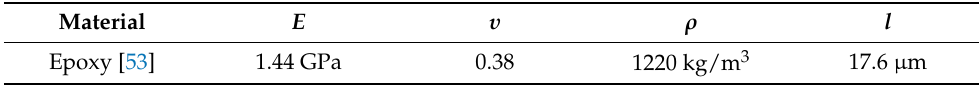
Table 1. Material properties of epoxy.